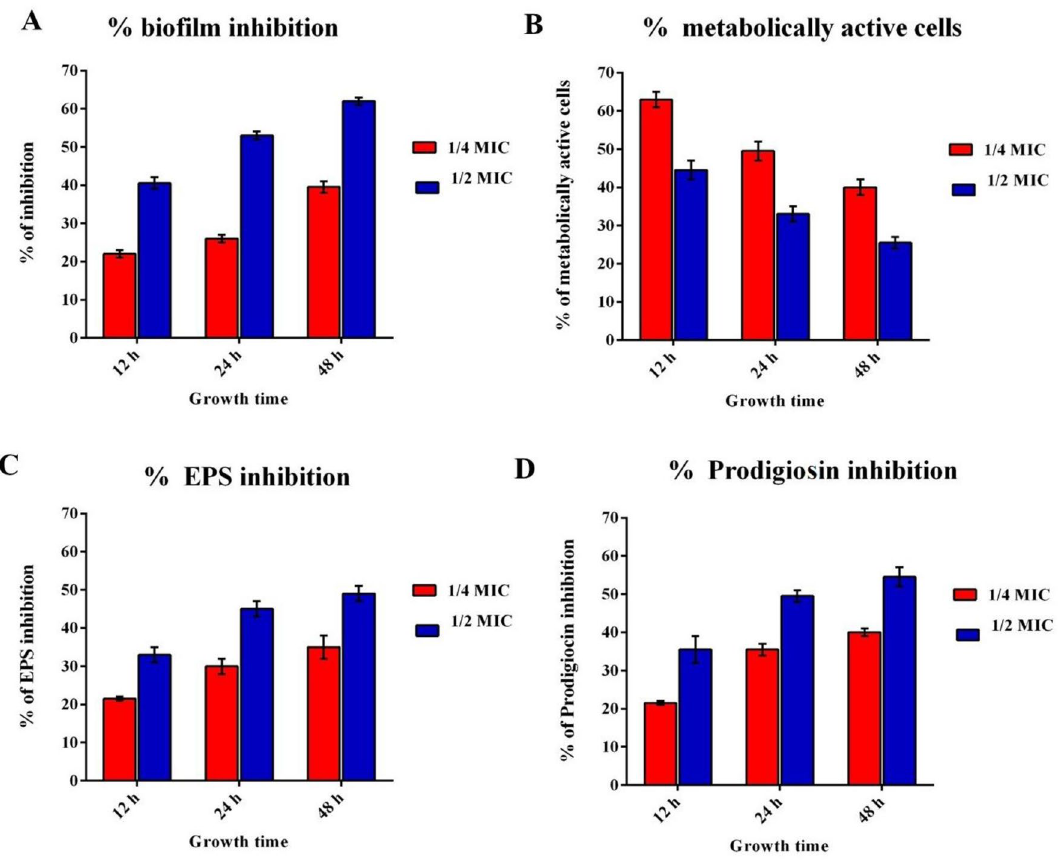
Figure 1. Percentage of inhibition of ( A ) Biofilm production ( B ) metabolic activity ( C ) EPS production ( D ) Prodigiosin synthesis exerted by quercetin on Serratia marcescens . All the assays were done in triplicates and the values were expressed as mean ±